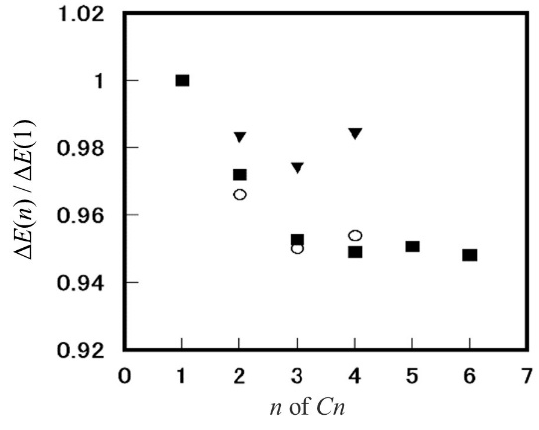
Figure 14. Atom number ( n ) dependence of the relative energy loss per ion ∆ E ( n ) / ∆ E ( 1 ) calculated for a C n + ( n = 2 − 6 ) ion incident at E = 0.5 MeV/atom on carbon foil of thickness d . Inclusion of average charge reduction ( d = 400 a 0 ( (cid:4) ), d = 480 a 0 ( )) and without average charge reduction ( d = 480 a 0 ( (cid:72) )) [22].